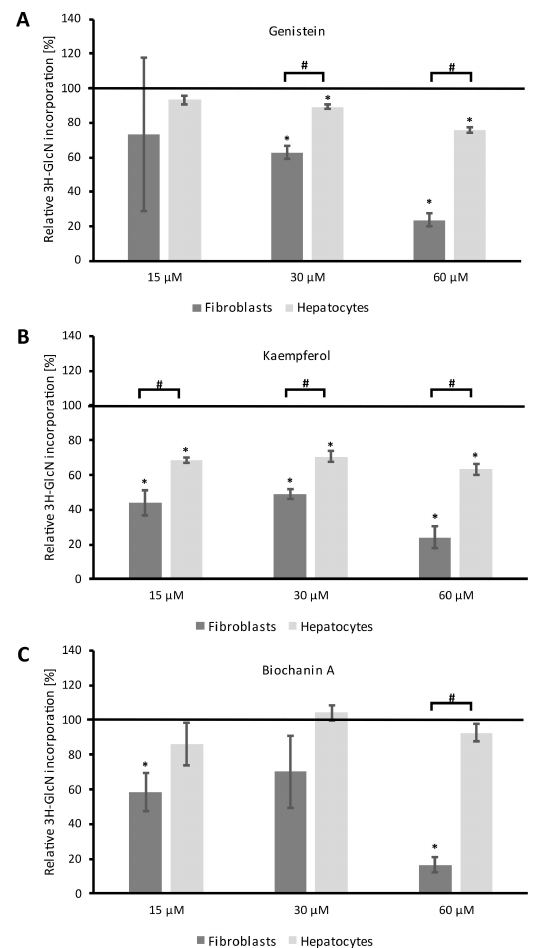
Figure 5. The level of GAG synthesis in fibroblasts and primary hepatocytes after 48 h of exposure to single flavonoids: genistein ( A ), kaempferol ( B ), and biochanin A ( C ) at final concentrations of 15 µ M, 30 µ M, and 60 µ M respectively, measured by D-[1-3H]-glucosamine incorporation assay. The black line (100%) corresponds to metabolic activity in control cells treated with 0.05% DMSO. Bars represent the average ± SD obtained for two different cell cultures from two different experiments. An asterisk (*) indicates statistically significant differences from control cells (ANOVA with Tukey’s post hoc, p < 0.05); hashtag (#) indicates statistically significant differences between cell types ( t -test, p <